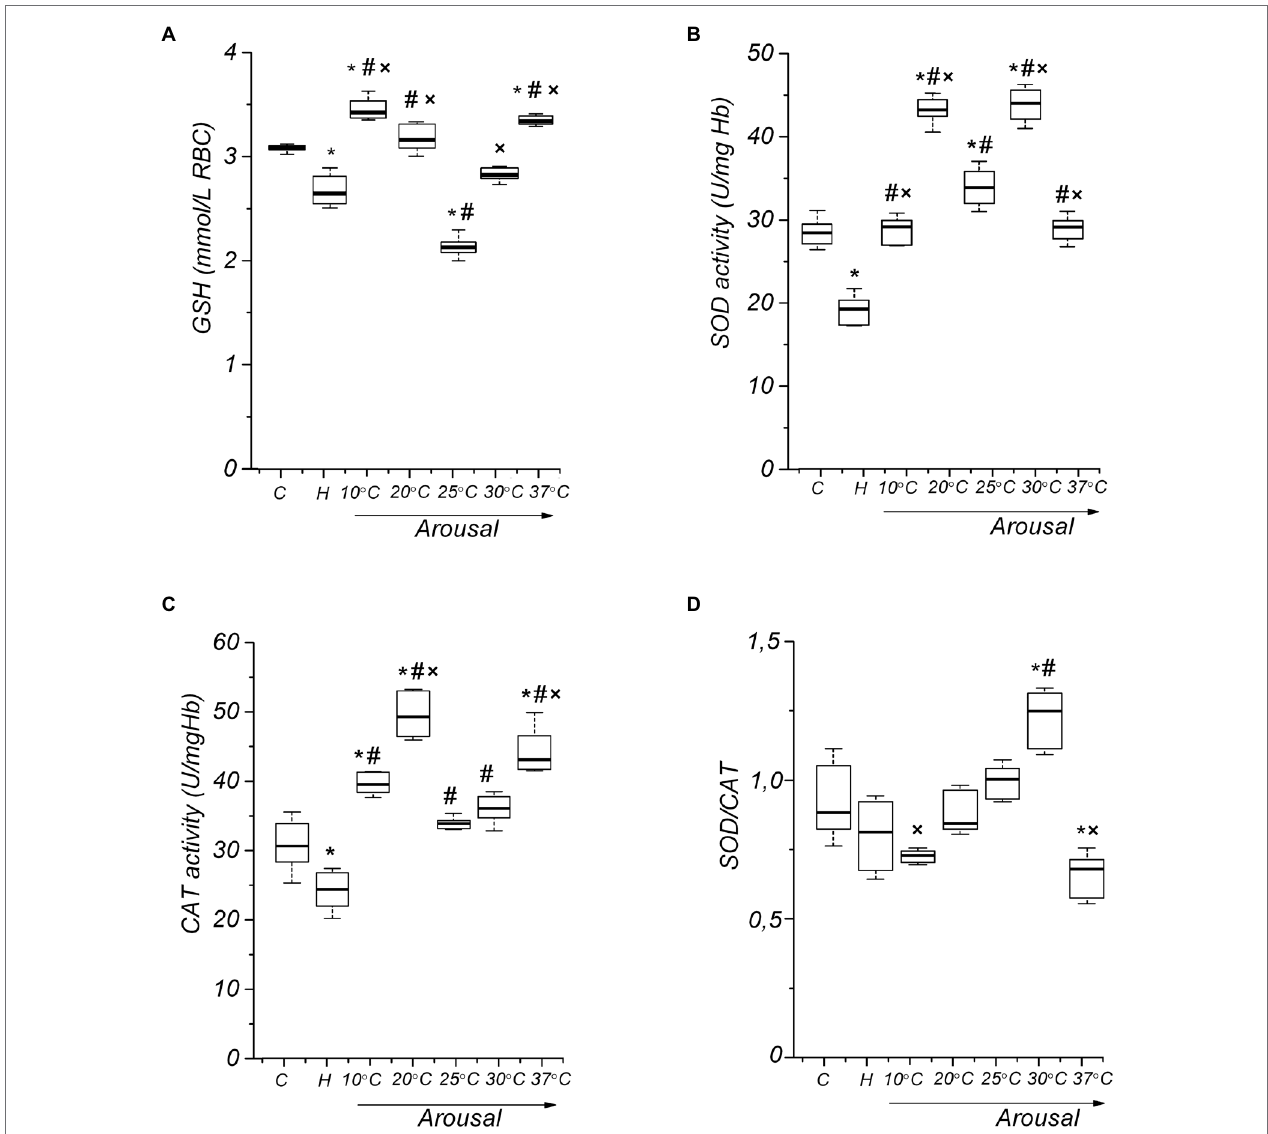
FIGURE 5 | Activity of RBC antioxidant defense components in ground squirrels during arousal from hibernation. Glutathione (GSH) level dynamics (A) , superoxide dismutase (SOD) activity (B) , catalase (CAT) activity (C) , and RBC SOD/CAT ratio (D) during torpor and arousal ( n = 14). C, control; H, hibernation; and body temperature ( ° C). Data are presented as box plots that show the median, 25/75 percentiles (box), and 10/90 percentiles (bars). * p < 0.001, compared with C; # p < 0.001, compared with H; × p < 0.001, compared with Tb 25 °